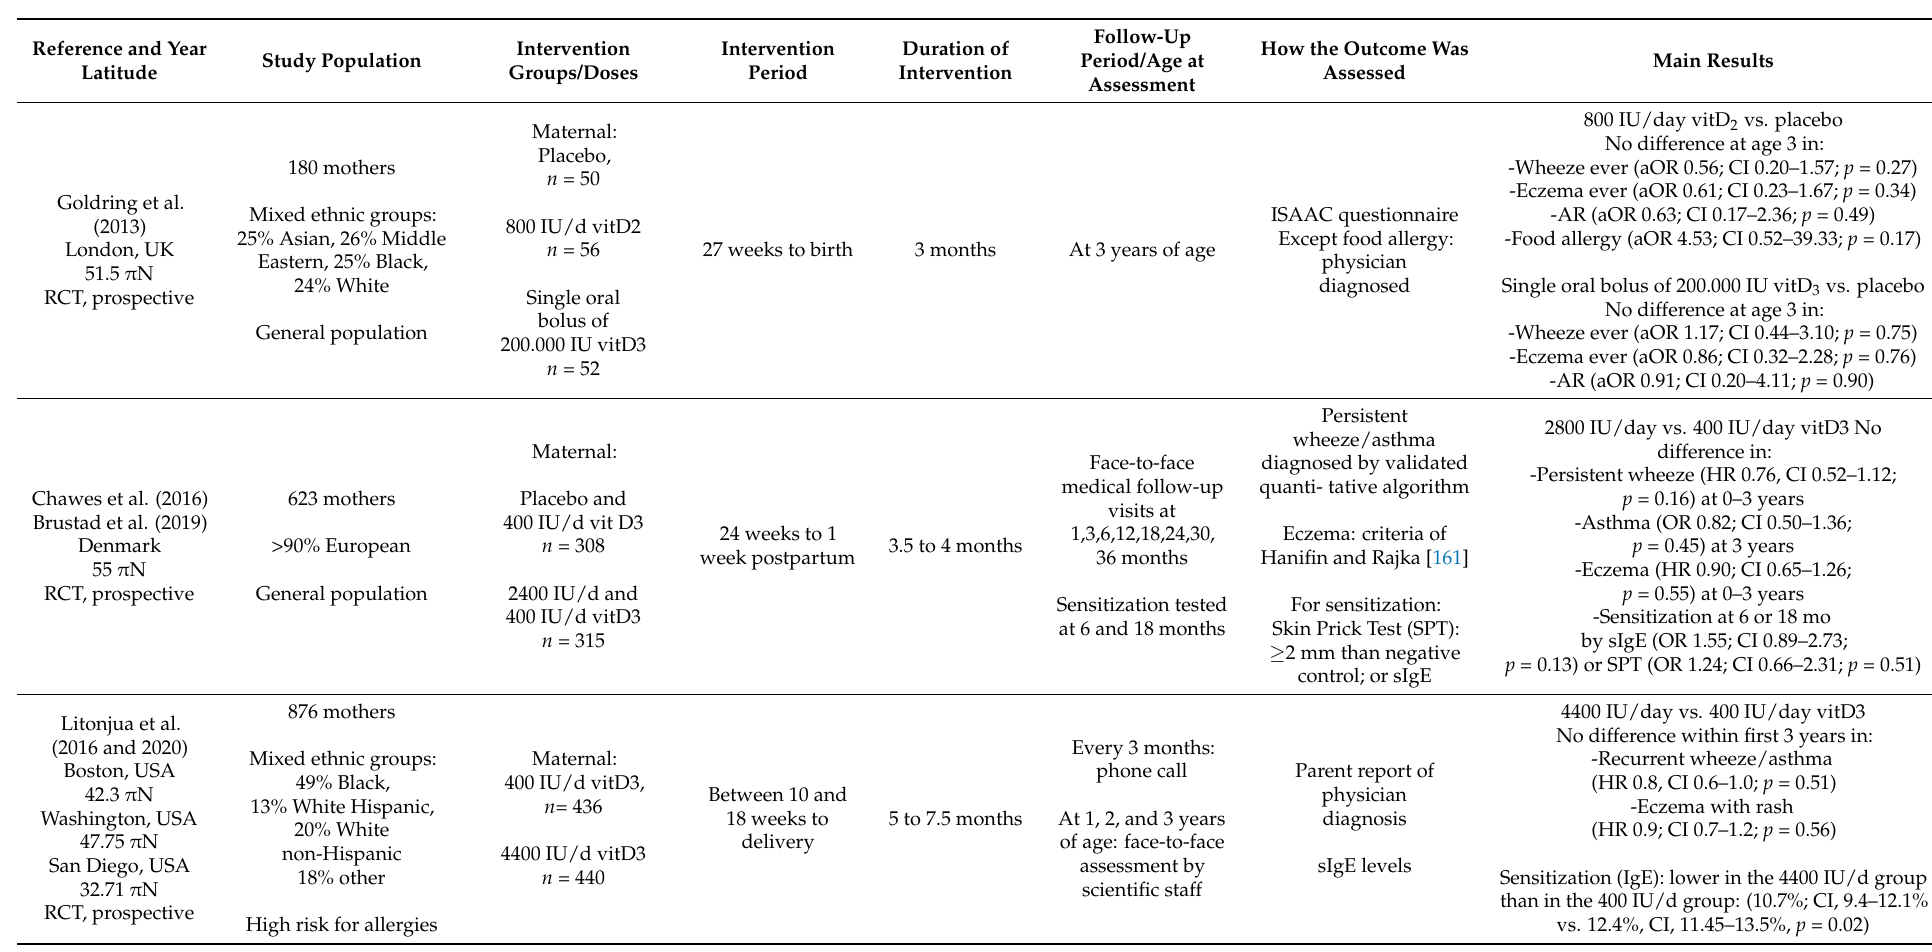
Table 2. Randomized controlled trials of prenatal intake of vitamin D and allergic outcomes in early